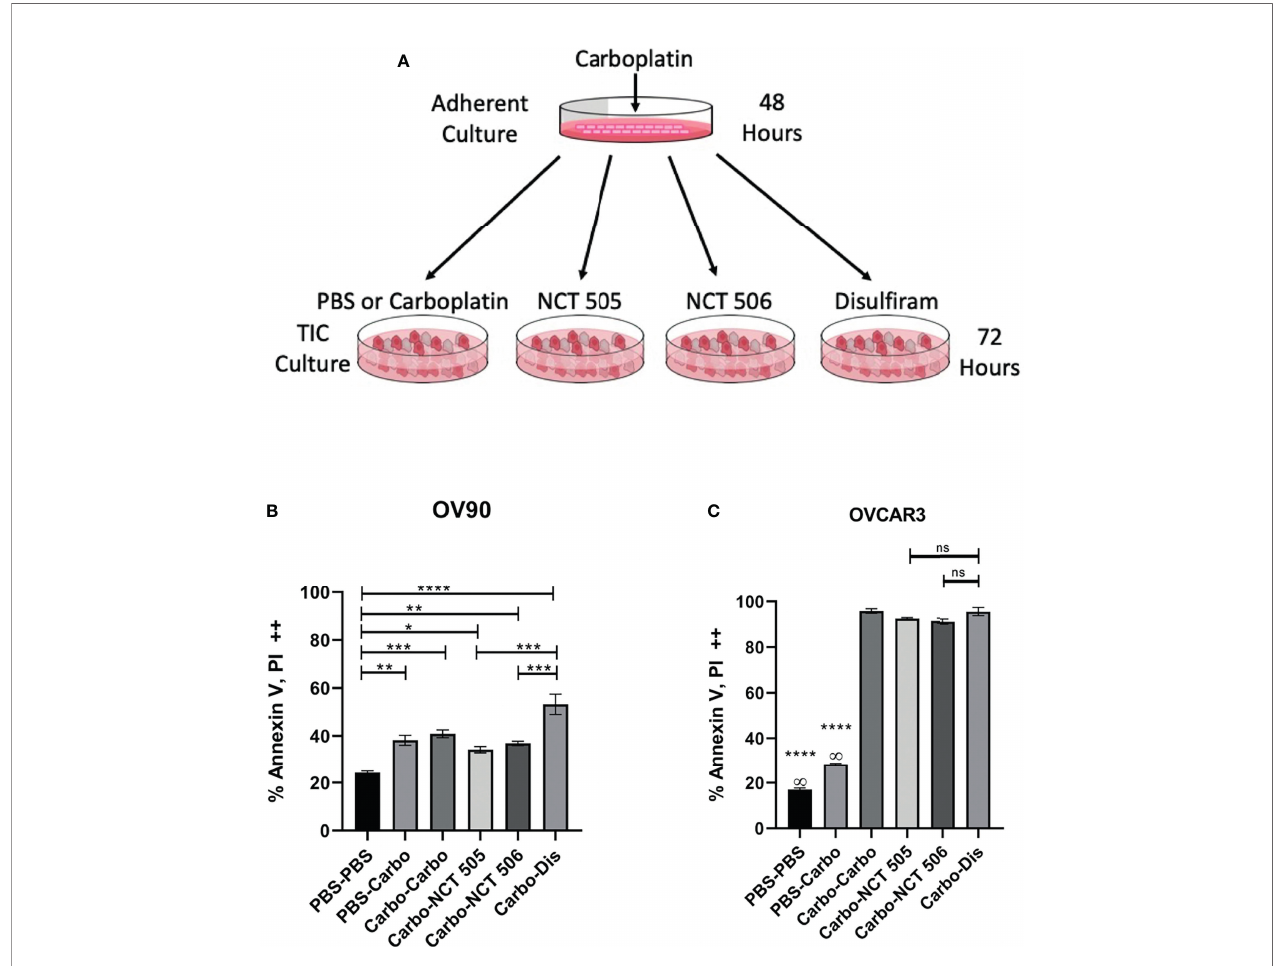
FIGURE 5 | The effect on cell death of ALDH inhibitors in an in vitro relapse model. (A) Schematic of in vitro relapse model outlining 48-hour treatment with carboplatin in adherent cells followed by 72-hour treatment with the NCTs and disul fi ram in TIC-enriching conditions. (B) OV90 and (C) OVCAR3 cells were treated with carboplatin at IC 50 doses (30 µM and 12.5 µM respectively) for 48 h in adherent conditions, then washed and replated in spheroid conditions for 72 h in the presence of IC 50 doses of NCT-505, -506, and disul fi ram. Cell death was quanti fi ed by fl ow cytometry analysis of cell populations double positive for both cell death markers Annexin-V and PI. Graphs represent mean and SEM of each treatment, from 3 independent experiments, ∞ , compared to all groups; ns, not signi fi cant, *p < 0.05, **p < 0.01, ***p < 0.001, ****p < 0.0001, compared to vehicle